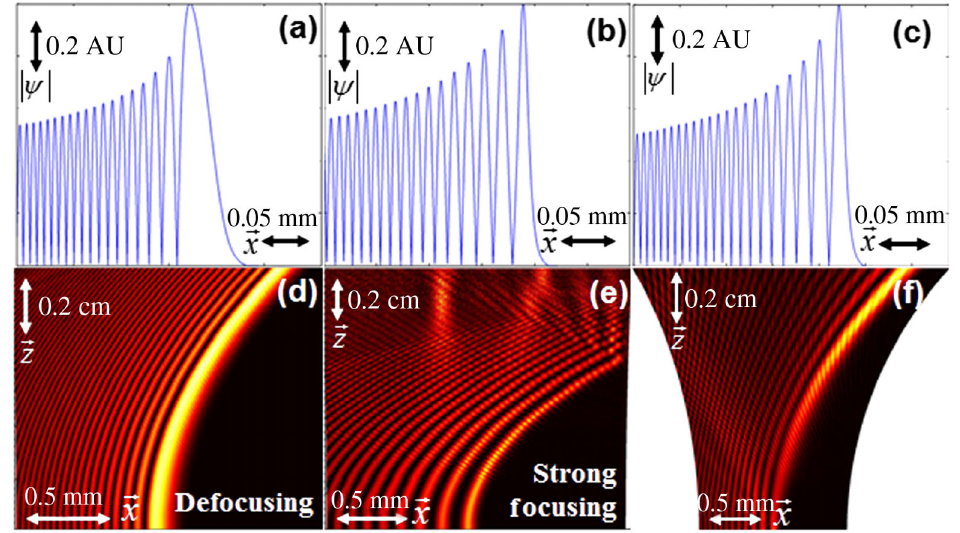
FIG. 4. (a) – (c)Profileofa nonlinearacceleratingwavepacketincurved space under (a)defocusing and(b),(c) focusingKerrnonlinearity. The profile differs from the nonlinear accelerating beam: For the defocusing case, the lobes are wider than the linear Airy beam, whereas for the focusing case, the lobes are much thinner. (d) – (f) Evolution of the nonlinear wave packets [of (a) – (c)] on the surface area of a hyperboloid with random noise (of 2%). (d) Defocusing nonlinearity supports stable propagation, whereas (e) for strong focusing, the beam become unstable to noise. (f) Evolution of the beam of (e) under different surface parameters can stabilize the